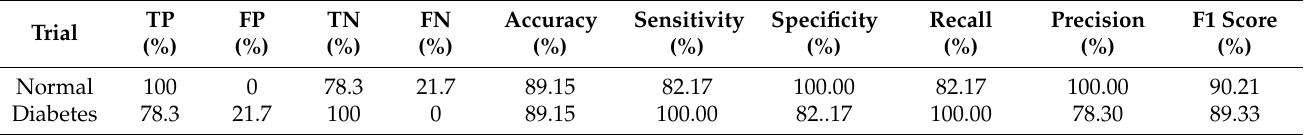
Table 5. Classification performance of super vector machine classifier.